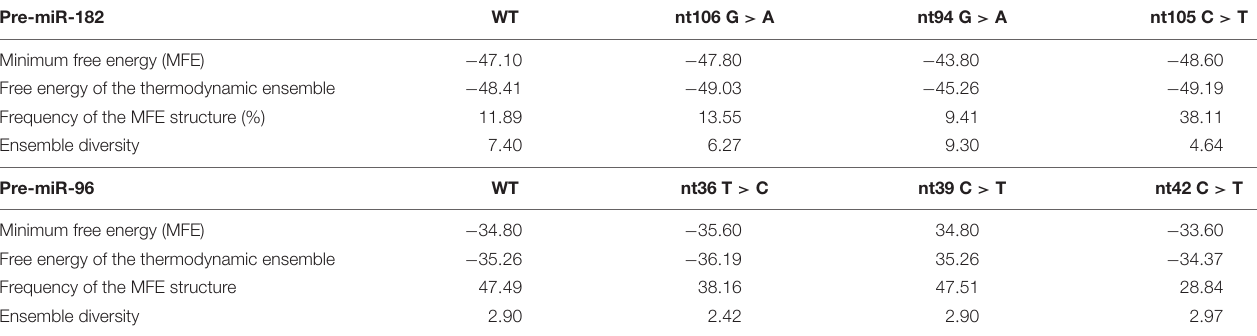
TABLE 3 | Changes in the predicted secondary structures and their free energy caused by the variants of pre-miR-182 (A) and pre-miR-96 (B). WT